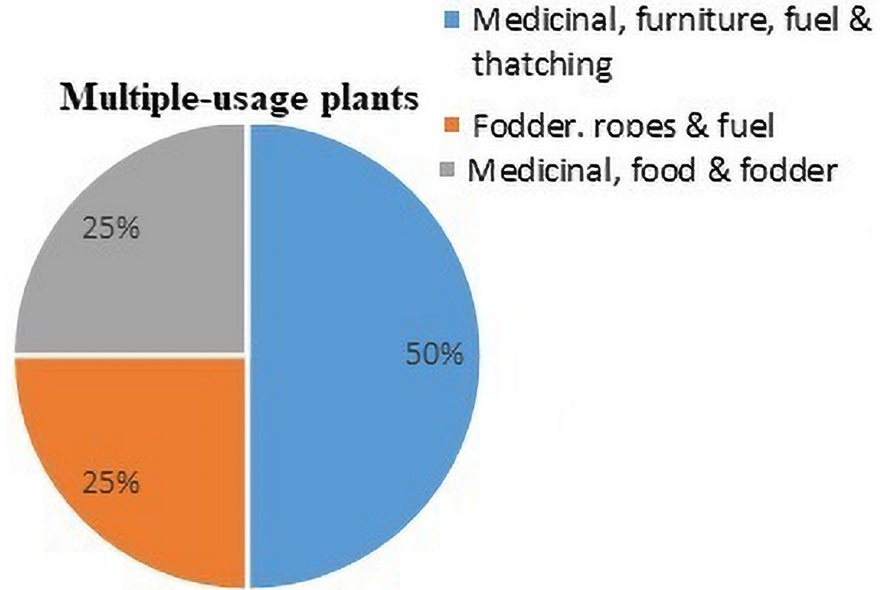
Fig 6. A pie chart of multiple-usage plants the basis of their usage from study area of Dawarian and Rati Gali, District Neelam of Azad Jammu and Kashmir, Pakistan.